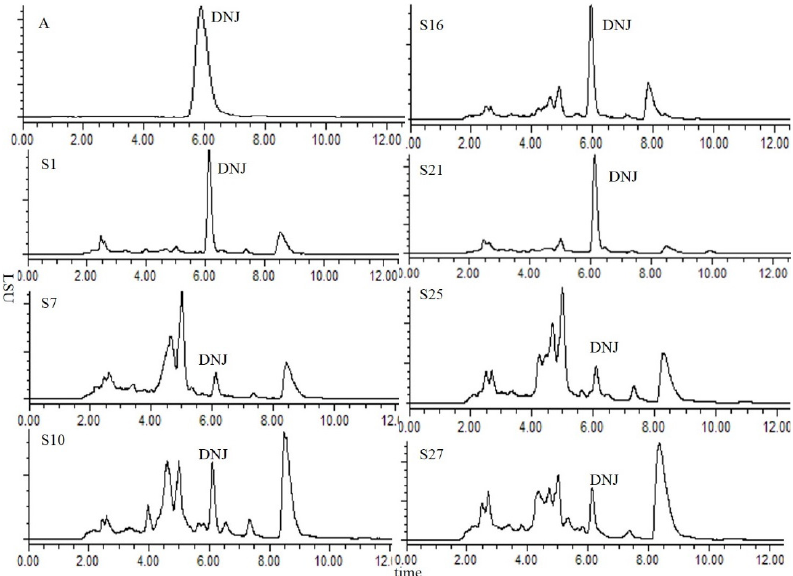
Figure 3. HPLC-ELSD chromatogram of DNJ. ( A ) DNJ standard chromatogram; the others are DNJ chromatograms of samples.